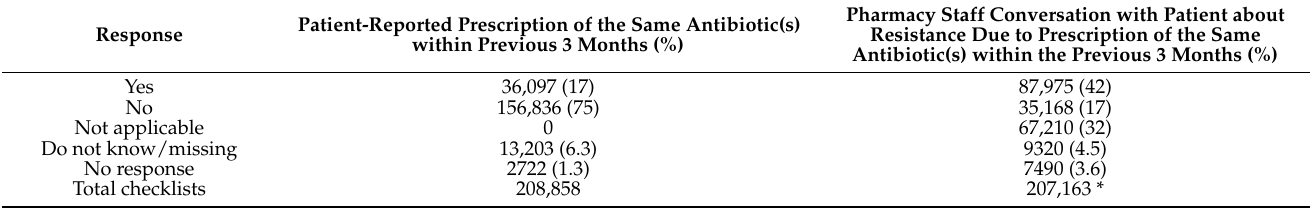
Table 2. Responses from both patient and pharmacist of using the same antibiotic in the last 3 months (n = number of checklists).